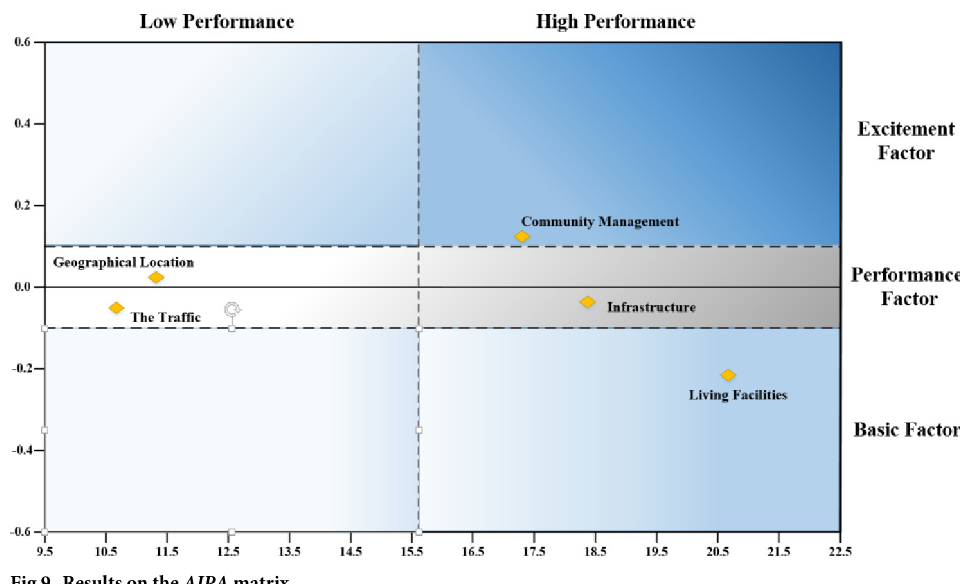
Fig 9. Results on the AIPA